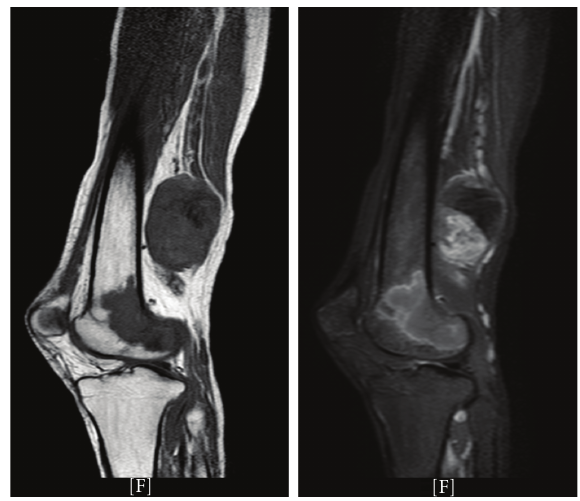
Figure 1: Urgent MRI of the right lower limb; T1 weighted (left), T2 weighted (right). A large (approx. 15 cm), oval, smoothly defined heterogenous mass with a large necrotic centre is clearly visible be- hind the lower femur (white arrows). There is also an area of al- tered signal within the femur itself involving the condyle, suggest- ive of bony metastasis (white arrowheads). The likely diagnosis is malignant peripheral nerve sheath tumor (MPNST) with a di ff eren- tial diagnosis of lymphoma or other soft tissue sarcoma. The charac- ter and distribution of the pain could signify a sciatic nerve origin.